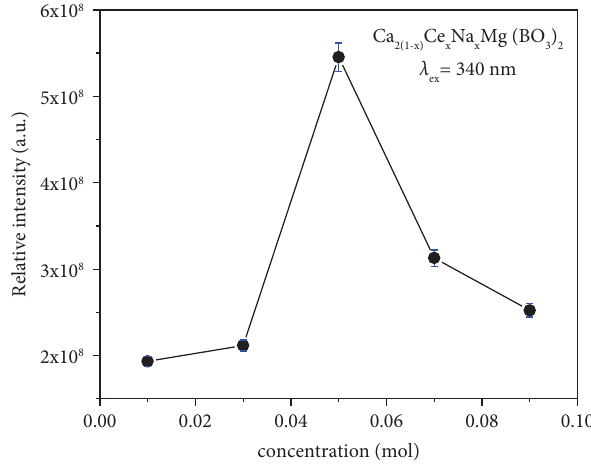
Figure 6: Te emission intensities of Ce 3+ as a function of its doping concentration ( x ) in Ca 2(1 − x ) Ce x Na x Mg(BO 3 ) 2 samples at